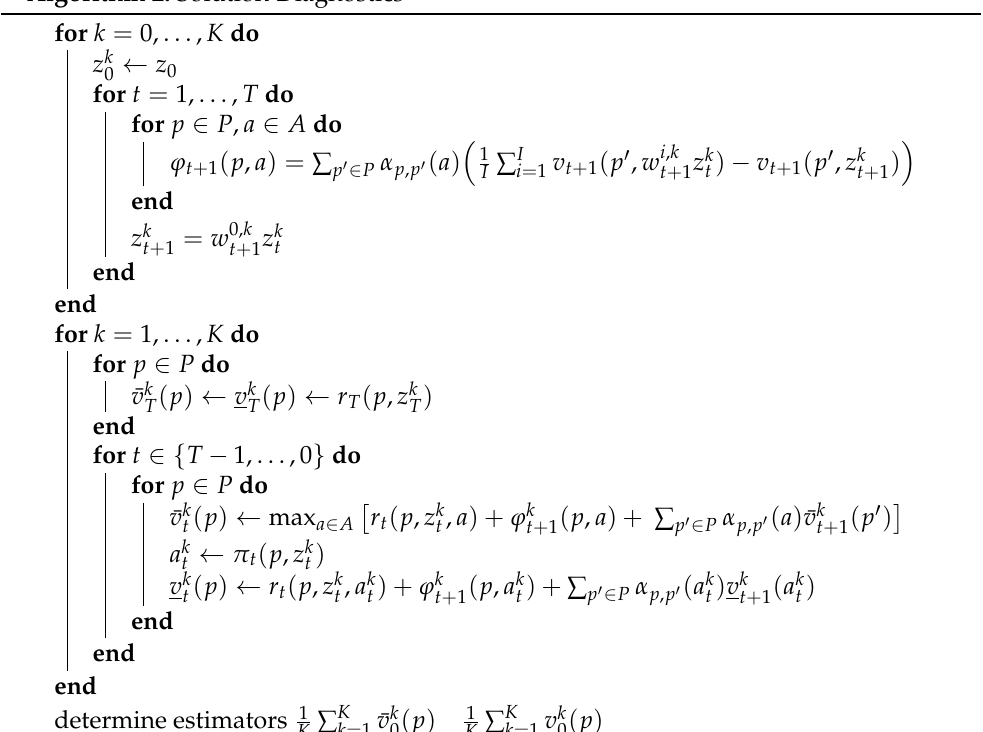
Algorithm 2: Solution